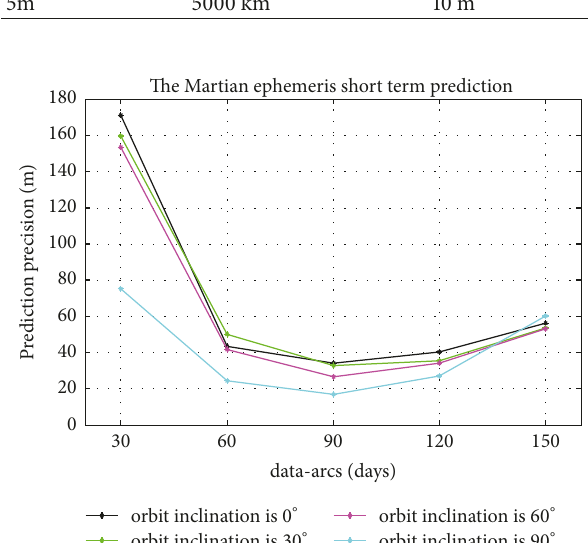
Figure 8: The Martian ephemeris short-term prediction with different probe orbit